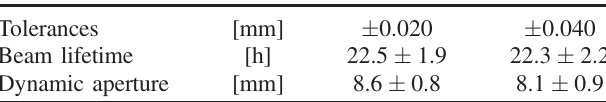
TABLE VII. Impact of mechanical tolerances on beam lifetime and dynamic aperture.